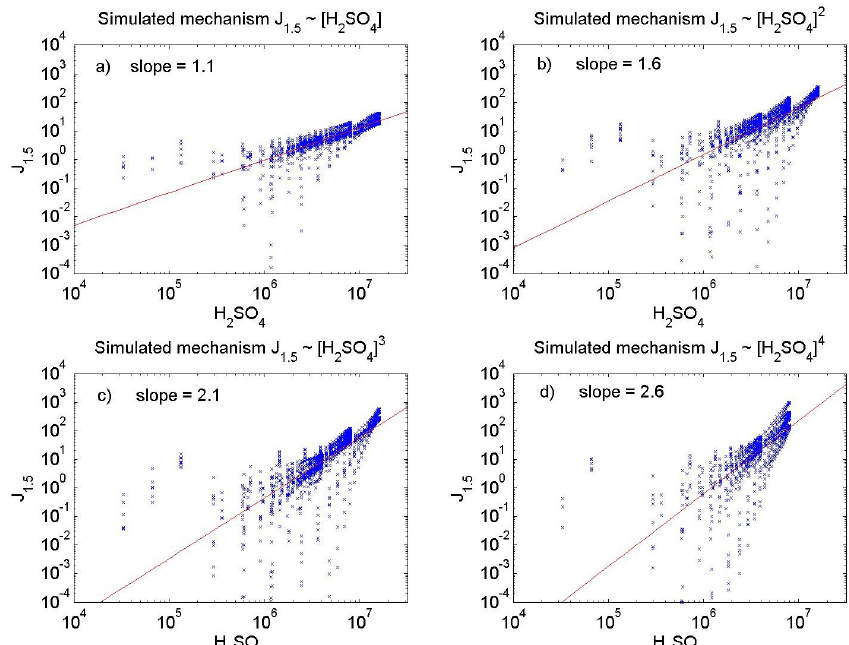
Fig. 7. The analysed nucleation rates J 1 . 5 versus simulated sulphuric acid concentrations for the four nucleation mechanisms: (a) J 1 . 5 ∼ [H 2 SO 4 ] (activation nucleation), (b) J 1 . 5 ∼ [H 2 SO 4 ] 2 (kinetic nucleation), (c) J 1 . 5 ∼ [H 2 SO 4 ] 3 , and (d) J 1 . 5 ∼ [H 2 SO 4 ] 4 . Only events which were simulated using the middle value for the nucleation coefficient (Table 1) and assuming a non-volatile organic compound are shown. The number of events plotted is (a) 29, (b) 30, (c) 34, and (d) 21. The regression line is shown in red.